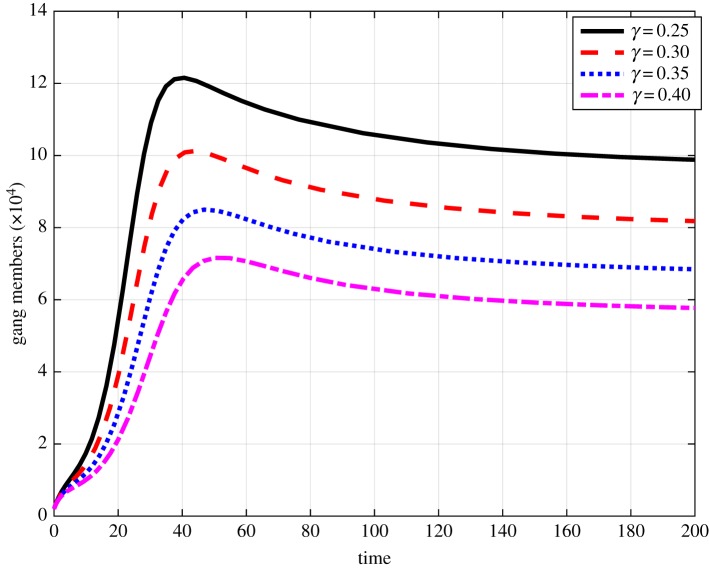
Impact ofvarying of γ on the prevalence of gang members where the time is in months.